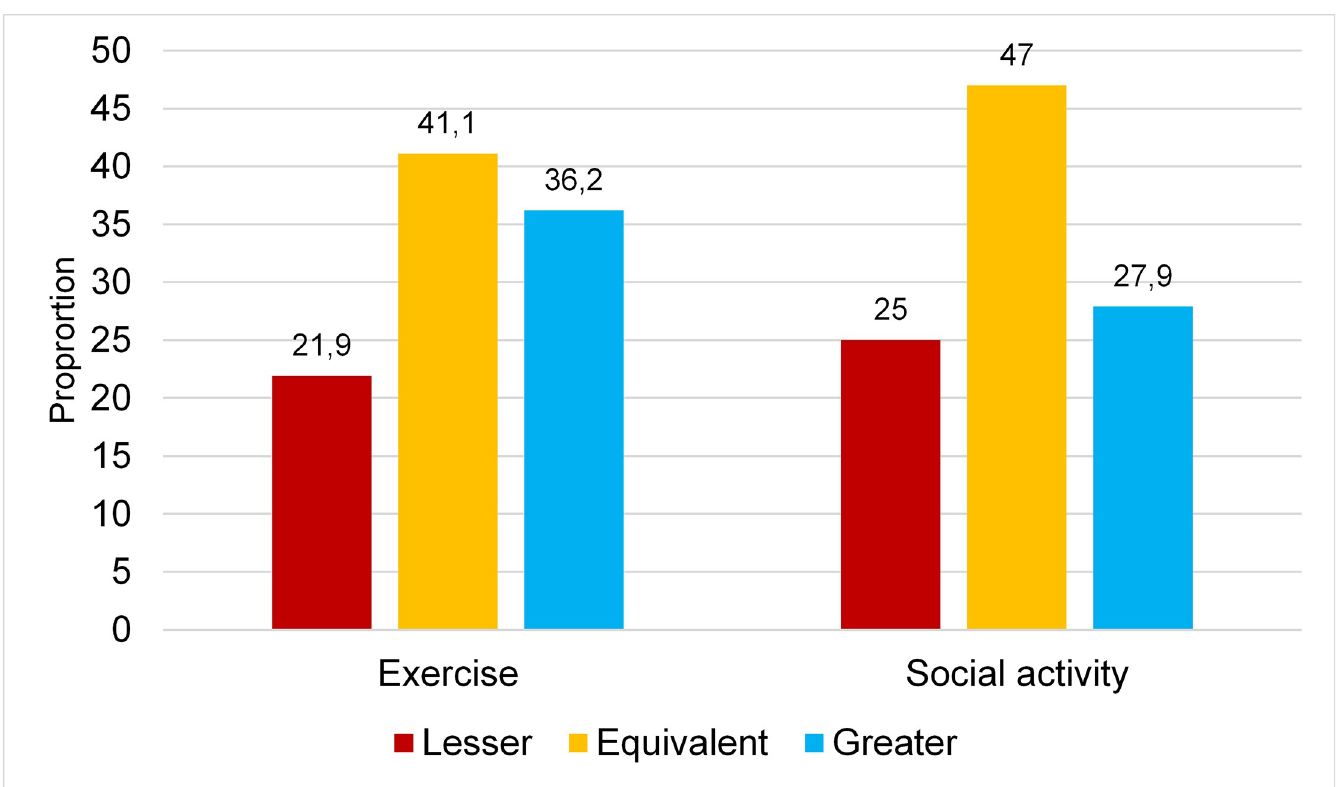
Fig 5. Motivation during activity sessions relative to motivation to go to activity sessions in the exercise and social activity groups.